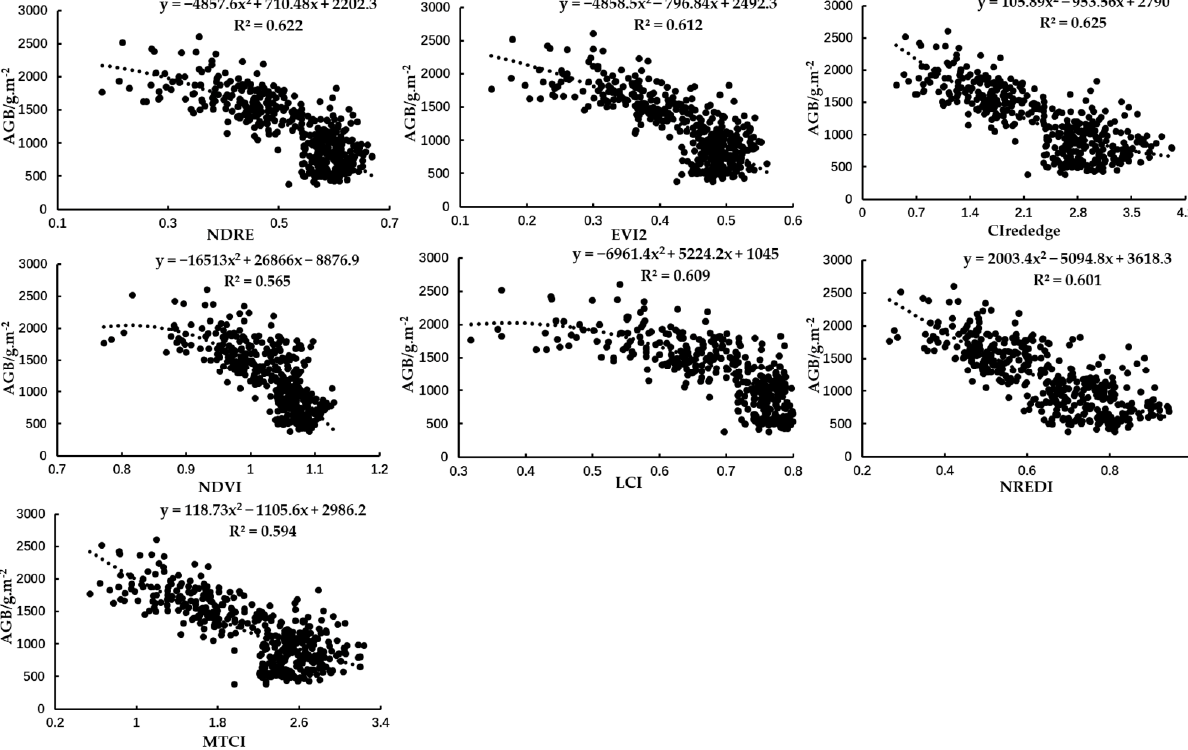
Figure 15. The fitting results of measured AGB and estimated AGB based on the partial least squares regression (PLSR) model.